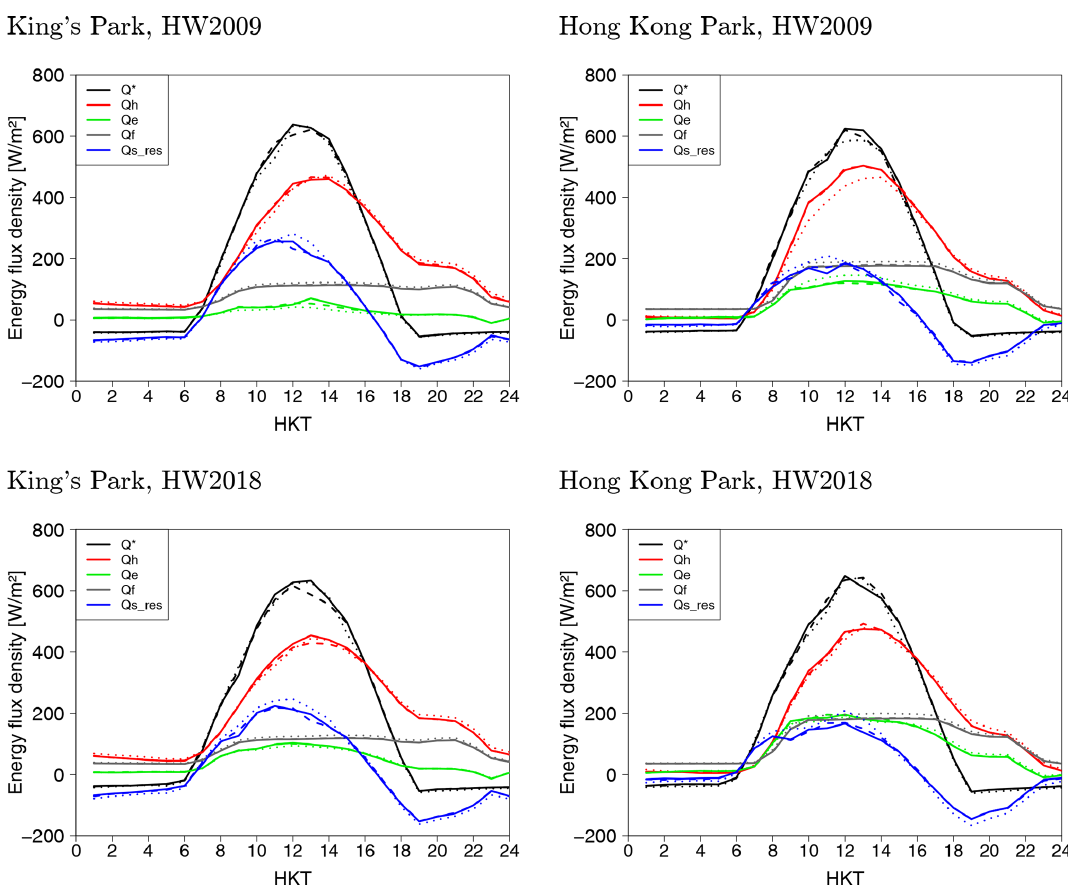
Figure 15. Daily cycle of the surface energy balance averaged for the entire duration of the heat waves and 1km × 1km boxes centred on the King’s Park and Hong Kong Park stations. Q ∗ is the net radiation, Q h and Q e are the upwelling turbulent sensible and latent heat fluxes, respectively, Q f is the anthropogenic heat flux, and Q s is the storage heat flux, which is diagnosed as the residual of the other fluxes. The continuous, dashed, and dotted lines correspond to the NEW, SURFFLUX, and CLASSICAL coupling approaches, respectively. HKT denotes Hong Kong